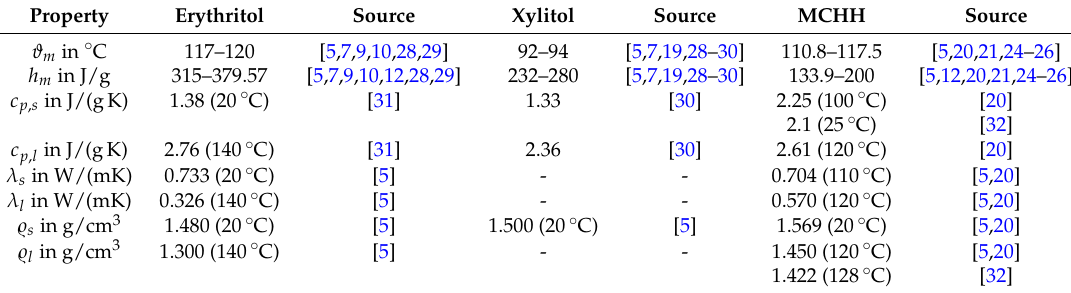
Table 1. Summary of literature values for the investigated